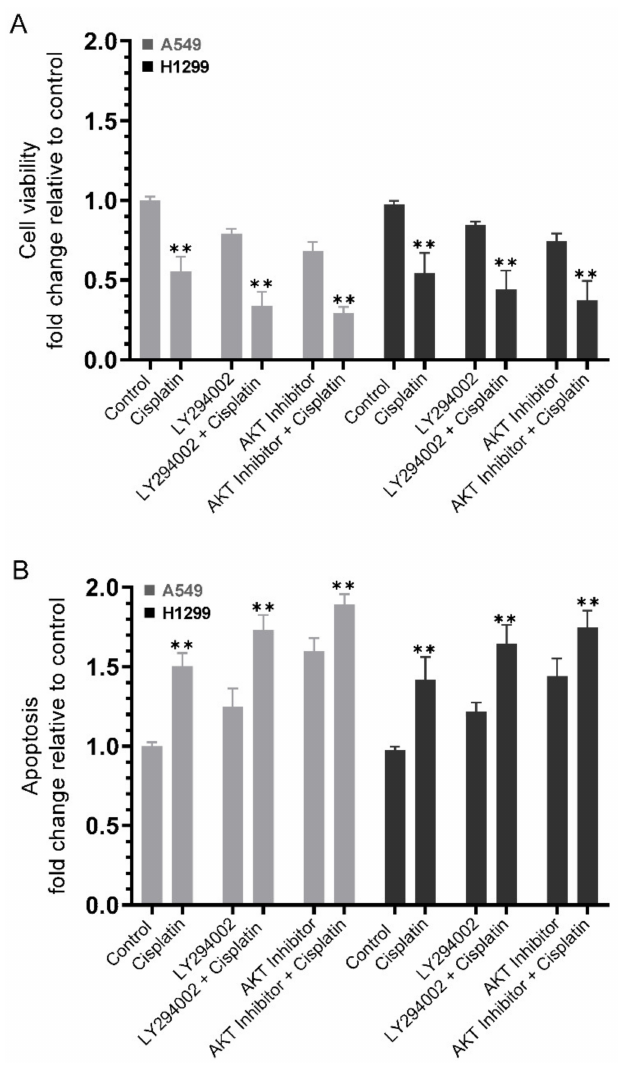
Figure 6. Cell sensitivity to cisplatin increased upon co-treatment of cells with inhibitors against PI3K and AKT. Cells (0.2 × 10 5 ) were grown in 10% FBS-supplemented media for 24 h. The following day, the cell monolayers were incubated in serum-free media for 24 h, then treated as indicated for 72 h with inhibitors targeted against PI3K (LY294002, 14.5 µ M) and AKT (AKT inhibitor, 1.75 µ M) without or with 10 µ M cisplatin when using A549 cells and 30 µ M cisplatin when using H1299 cells. Cell viability ( A ) and apoptosis ( B ) were then determined as described in the Methods section. Data from five independent assays, each carried out in triplicate, were averaged, normalized, and expressed as fold change relative to untreated cells (Control) using the GraphPad 9.4.1 software. The graphs summarize the results expressed as means ± SD (n = 5). Asterisks indicate a statistically significant difference from the corresponding samples without cisplatin treatment for each cell line, Mann–Whitney test, ** p <